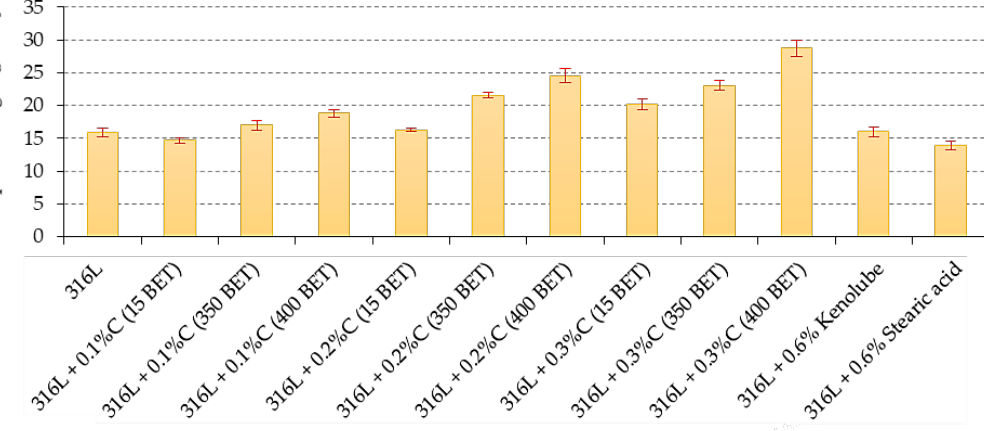
Figure 10. The impact strength of sinters depends on the percentage composition of mixtures. HRB hardness measurements were carried out on the sinter surface from the side of the upper (pressing) punch and the side of the lower punch (Figure 11). Analyzing the results obtained, it can be observed that the increase in the hardness of sintered particles depended both on graphite content and the BET specific surface area of its particles; the more developed the specific surface area of graphite powder added to austenitic stainless